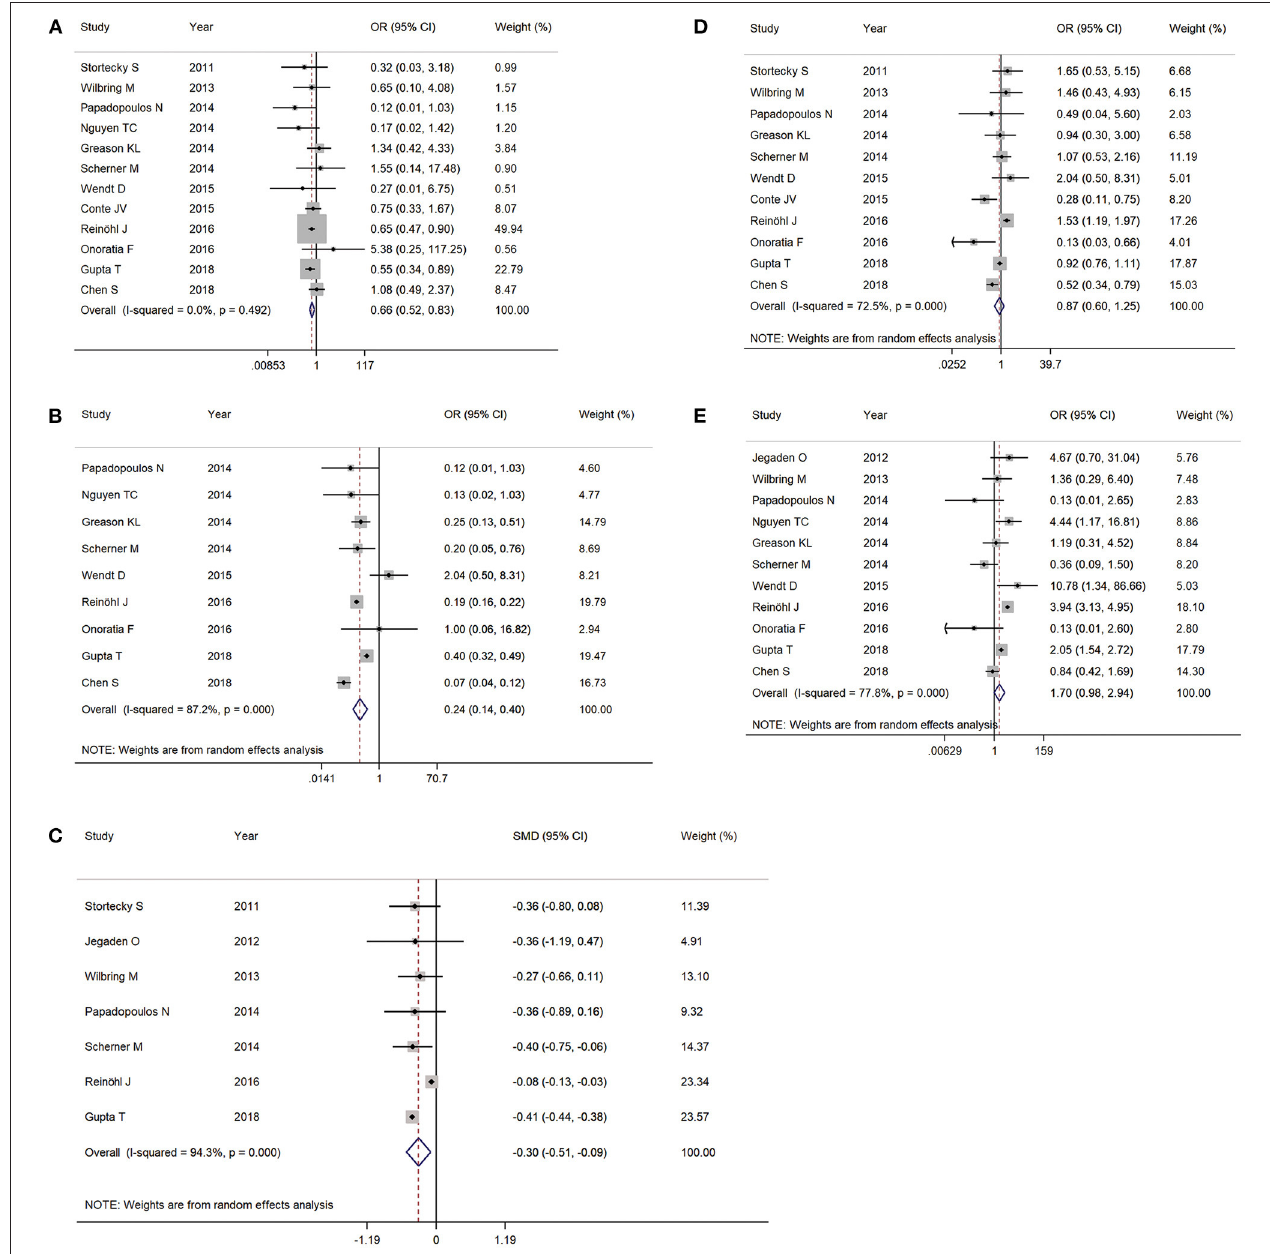
FIGURE 3 | The meta-analysis for post-procedural complications as (A) stroke, (B) bleeding (major or worse), (C) length of stay, (D) acute kidney injury, and (E) permanent pacemaker implantation.